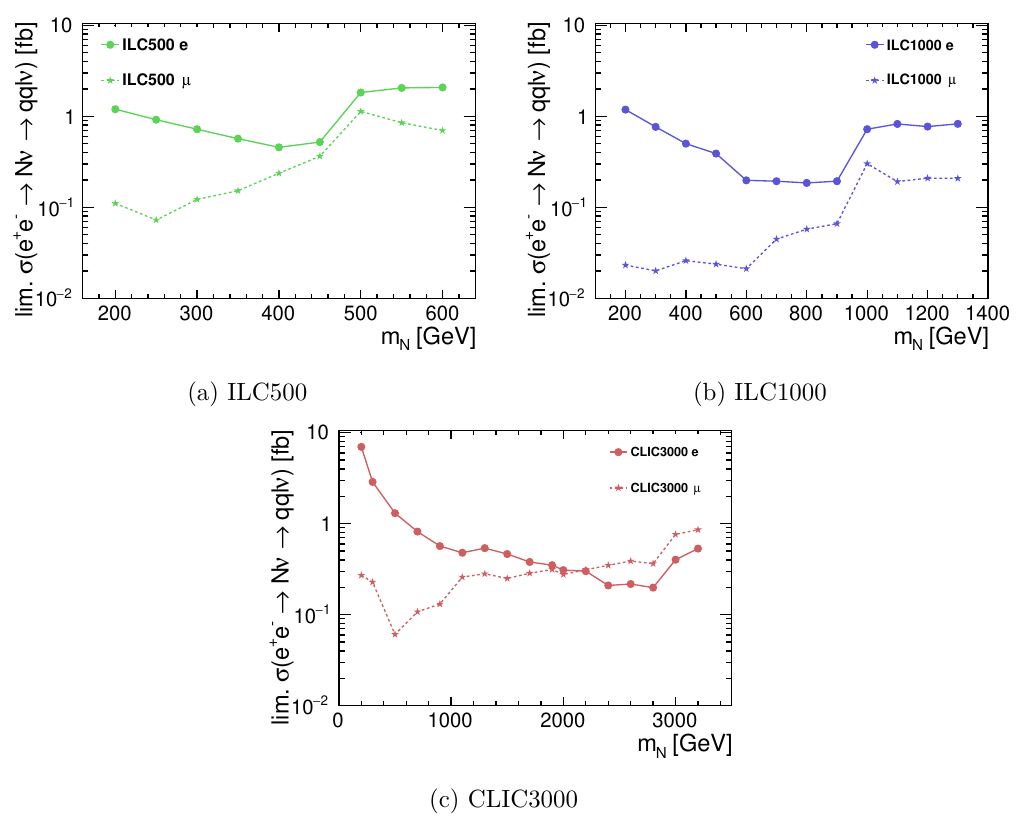
Figure 8. 95% C.L. limits on the cross section of heavy Dirac neutrino production and decay (the qq‘ν final state) as a function of the neutrino mass for different collider setups. Dots signify the analysis with an electron in the final state and stars that with a muon,